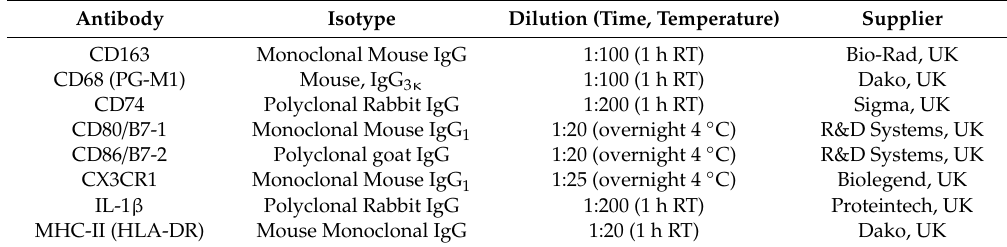
Table 9. Antibody sources and